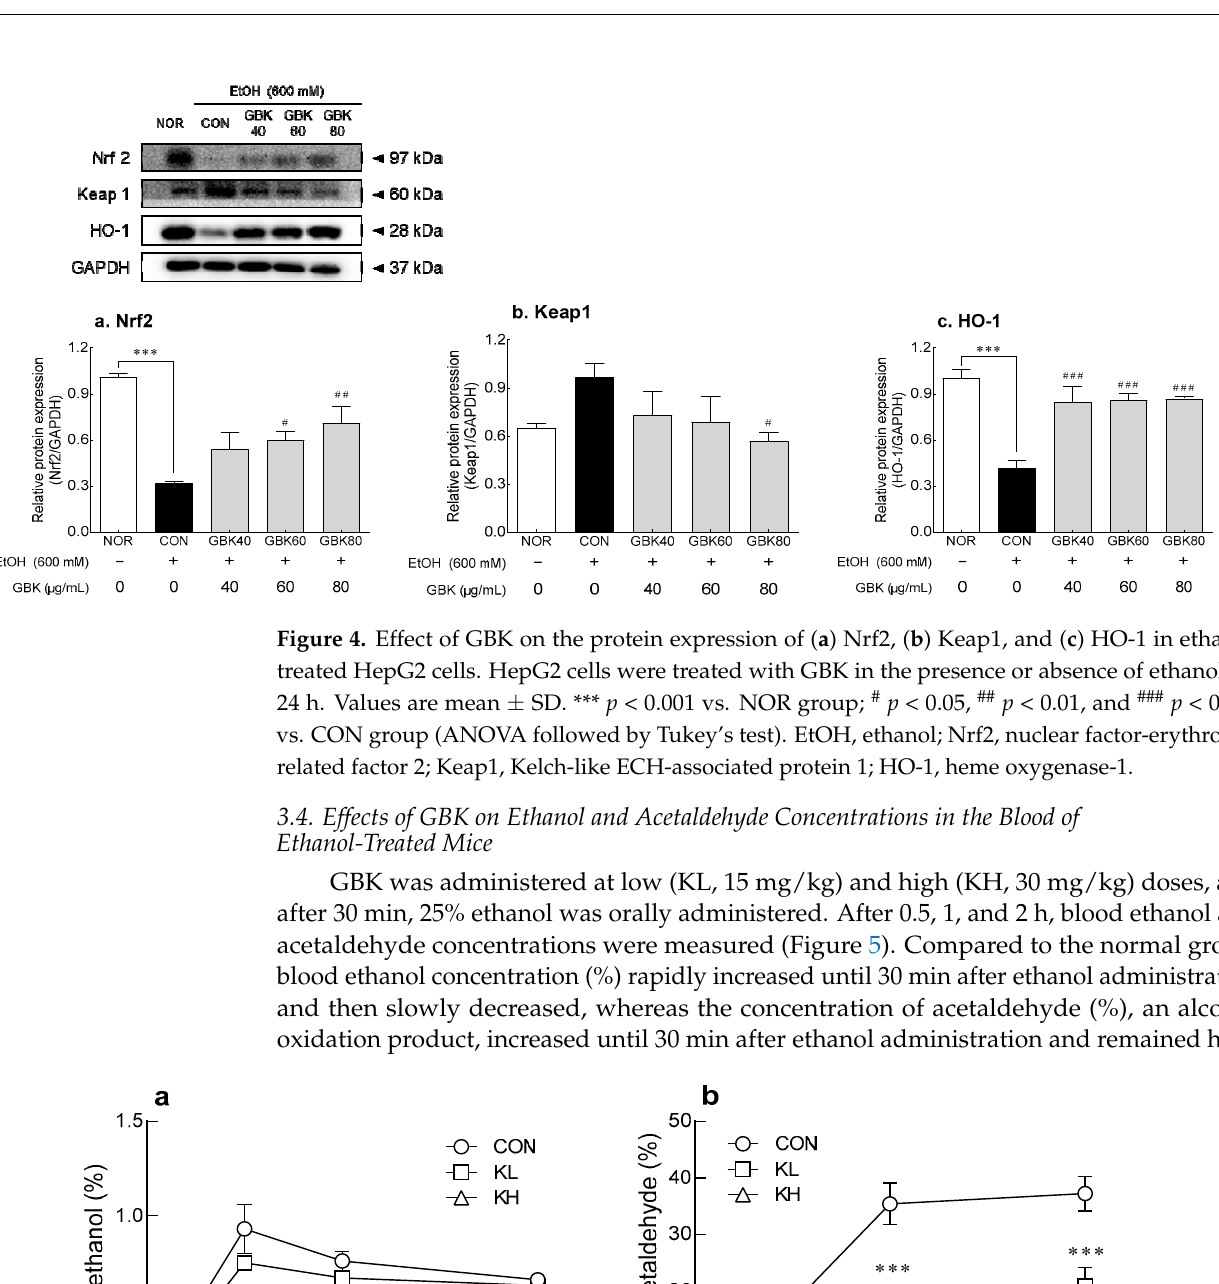
Figure 5. Effect of GBK on serum ( a ) ethanol and ( b ) acetaldehyde levels in mice. Values are mean ± standard of the mean (SEM). GBK was administered orally 30 min before ethanol administration. *** p < 0.001 vs. CON group (ANOVA followed by Tukey’s test). CON, control group; KL, low-dose GBK group (15 mg/kg); KH, high-dose GBK group (30 mg/kg).